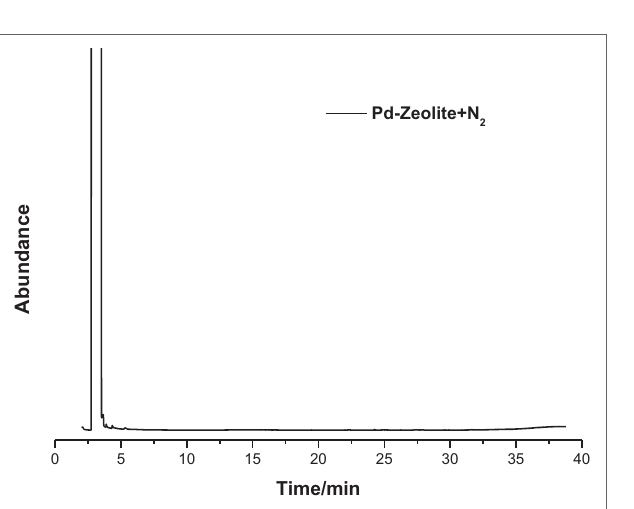
FIGURe 5 | Proposed reaction pathways for the formation of the major products from cleavage of the β -O-4 lignin.